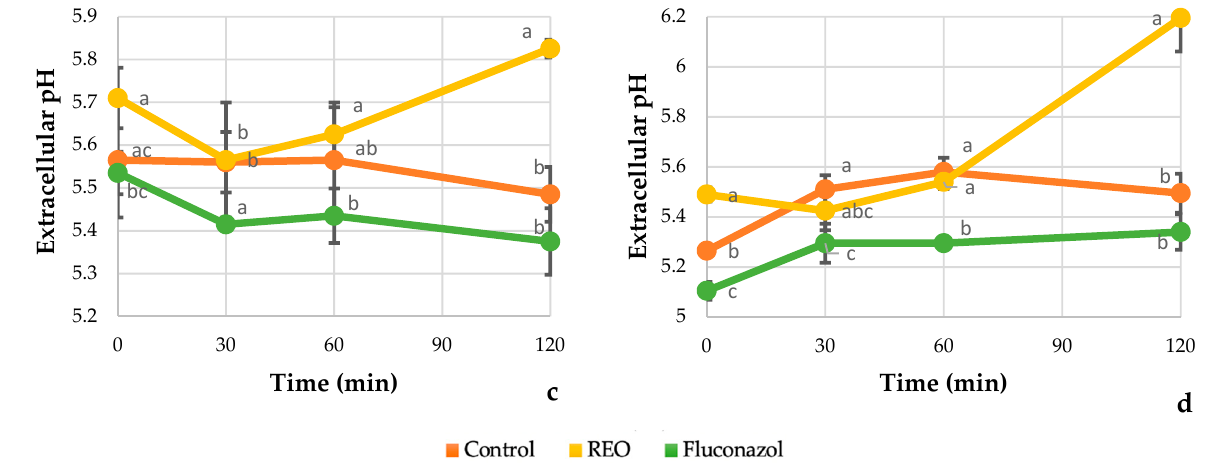
Figure 4. Extracellular pH of Candida yeast treated with REO and fluconazole. C. tropicalis ORL21 ( a ), C. tropicalis ORL20 ( b ), C. albicans ORL08 ( c ), and C. albicans ORL03 ( d ) with the treatment at different times. Values are the averages of the replicates for all the analyses. Error bars are ± SD of the means. Results are according to ANOVA test mean values and intervals based on Tukey test for treatments with 95%. Different lowercase letters (a, b, c) indicate significant differences between treatments according to the Tukey test in a confidence interval of 95%.